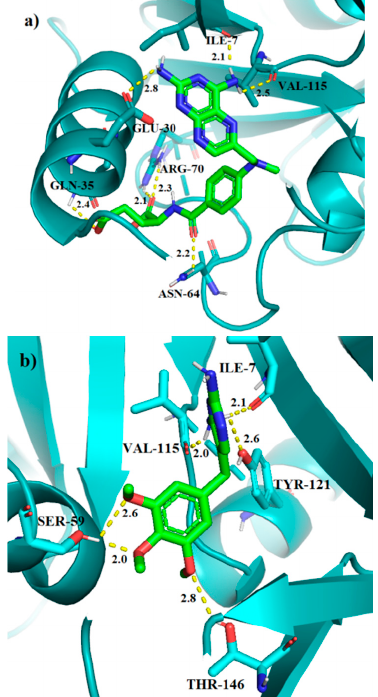
Figure 4. The binding modes of MTX ( a ), and TMP ( b ) in the active site of human DHFR. Hydrogen bond lengths in [Å].